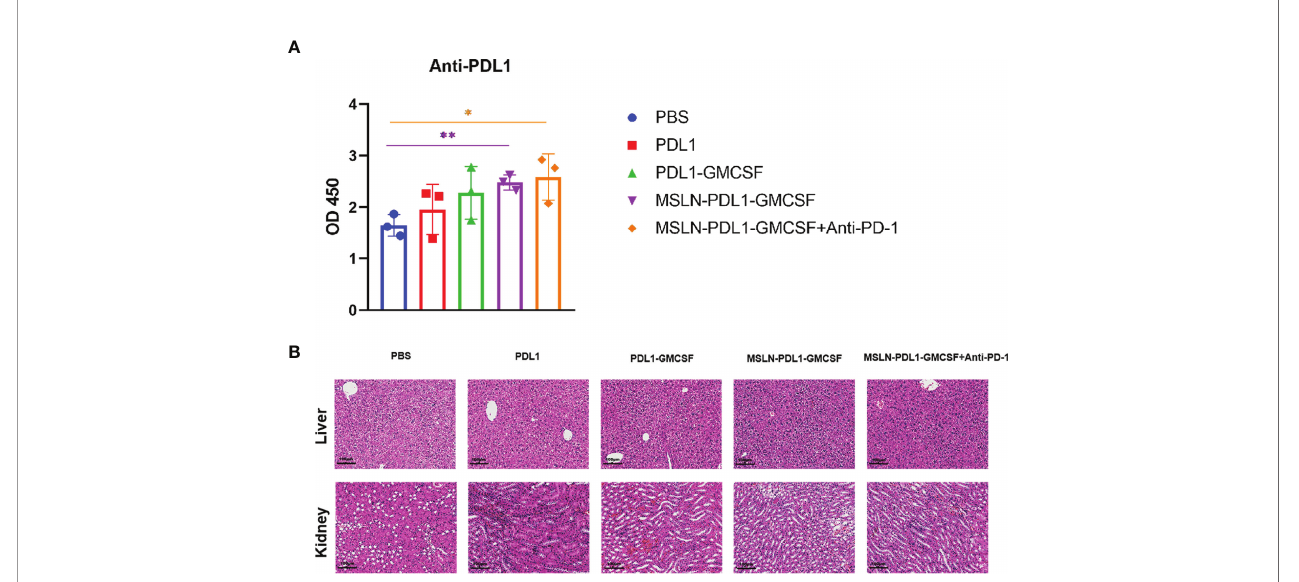
FIGURE 4 | Groups of C57BL/6 mice were immunized with protein-loaded DCs (1×10 6 cells/mouse) at twice weekly interval, and sera from each group mice were collected 3 days after the end of immunization. (A) PD-L1-speci fi c IgG levels from the sera of each group were determined by ELISA. (B) HE staining analysis of liver and kidney sections from each group of mice as described in “ Materials and Methods ” . The original magni fi cation of the images is ×10. Mean ± SD (n=3). *p<0.05, **p <